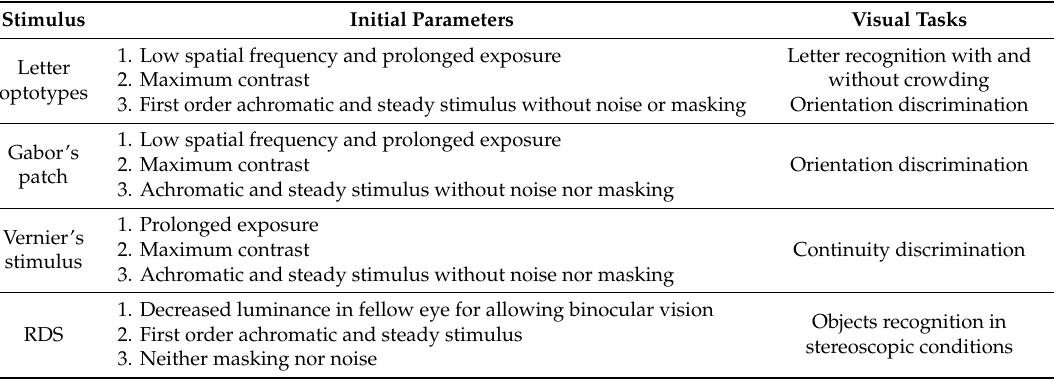
Table 3. Summary of the recommendations for the selection of visual tasks and the initial parameters of the stimulus that should be used in vision training for amblyopia according to the scientific evidence